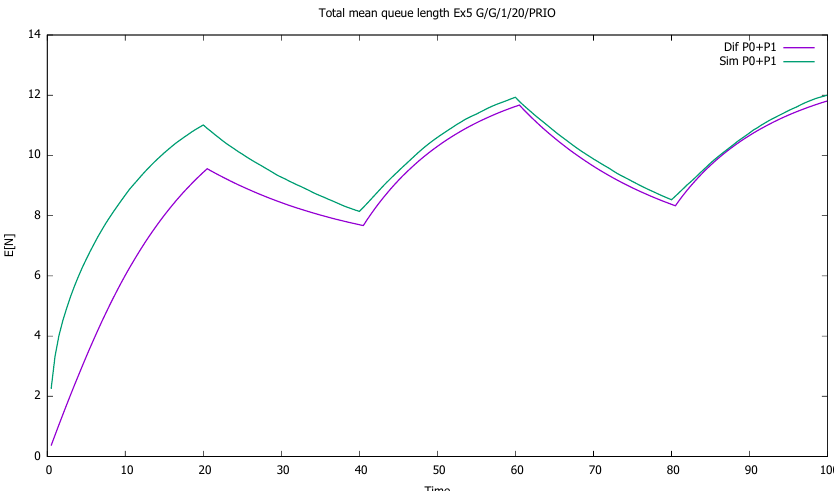
Figure 18. Section 3.5: total mean queue length of both priority classes for very high values of C 2